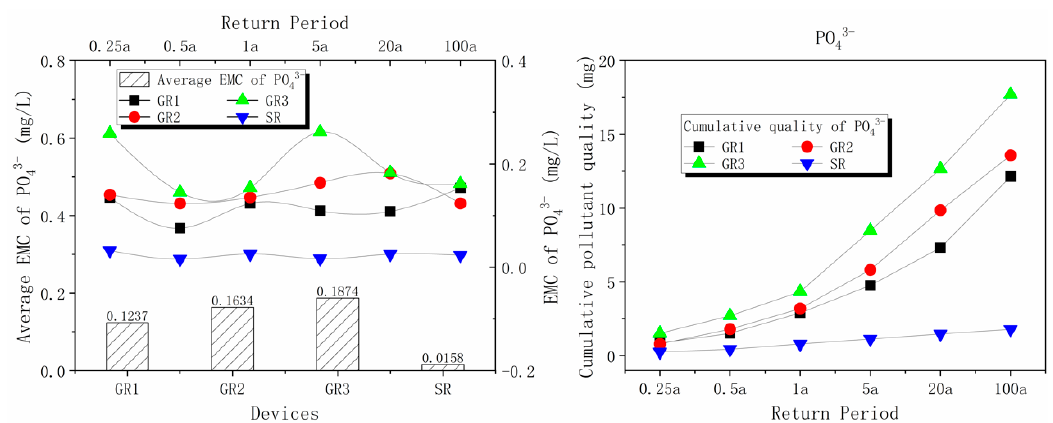
Figure 5. EMC and cumulative pollutant quality of PO 43 − .